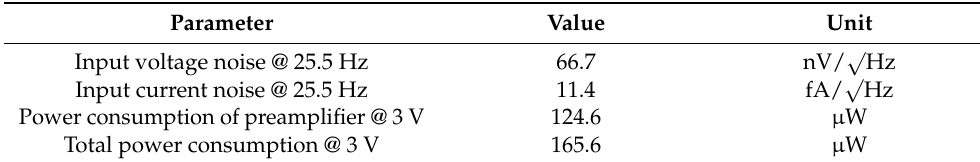
Table 5. Noise parameters and power consumption of the sensor interface.